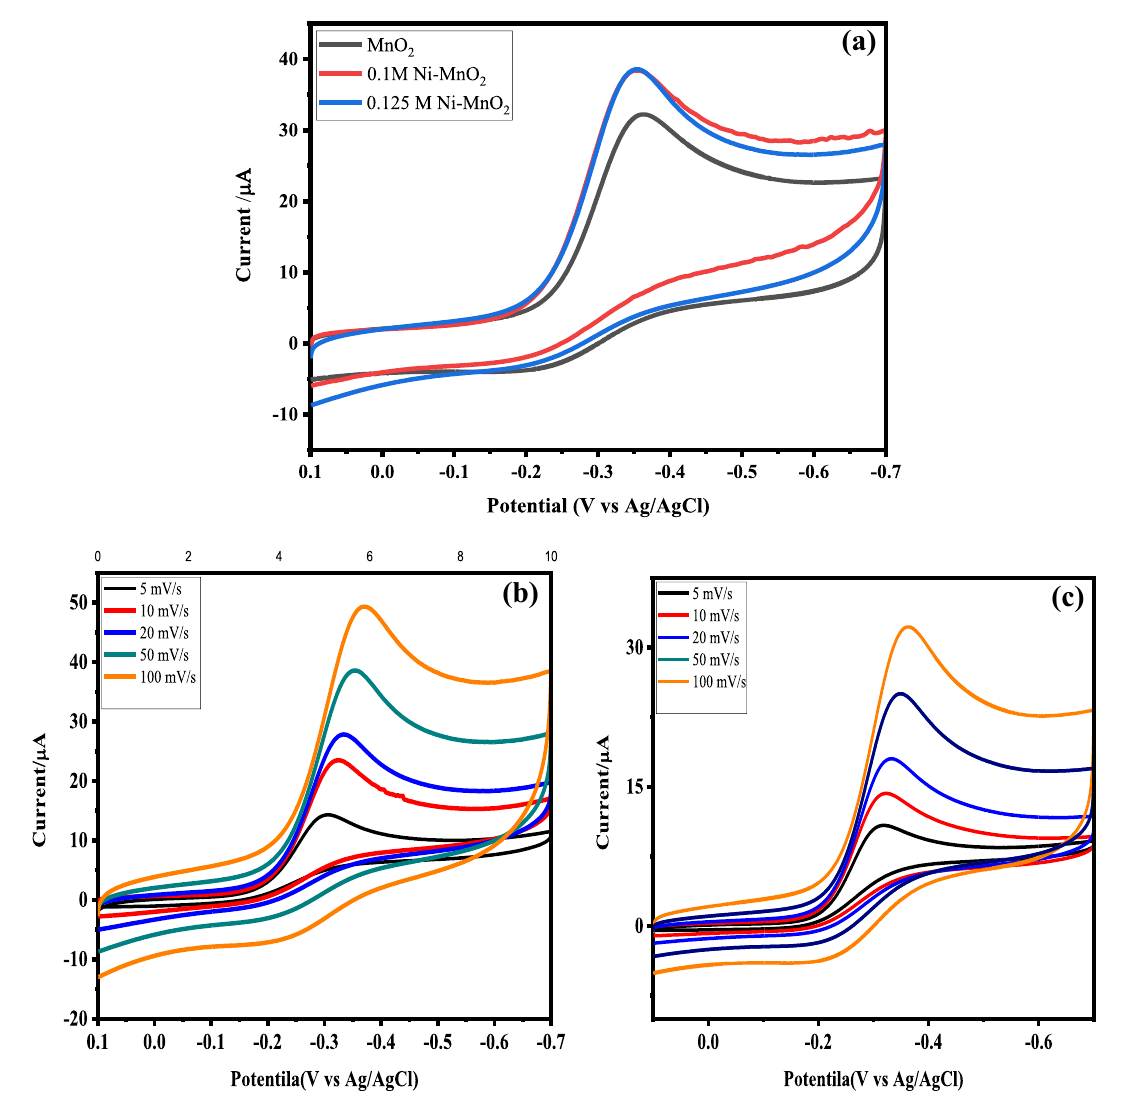
Fig. 11 CV curve of; a pure MnO and c MnO at different scan 2